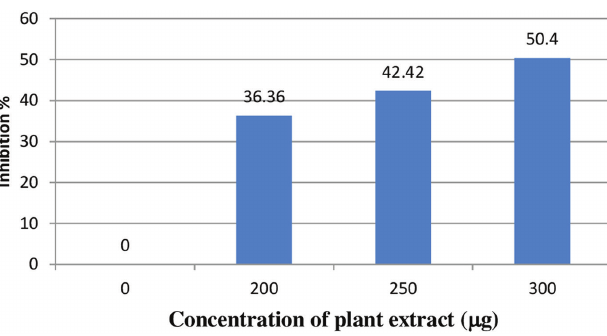
FIGURE 1 - Acetylcholinesterase inhibition assay.